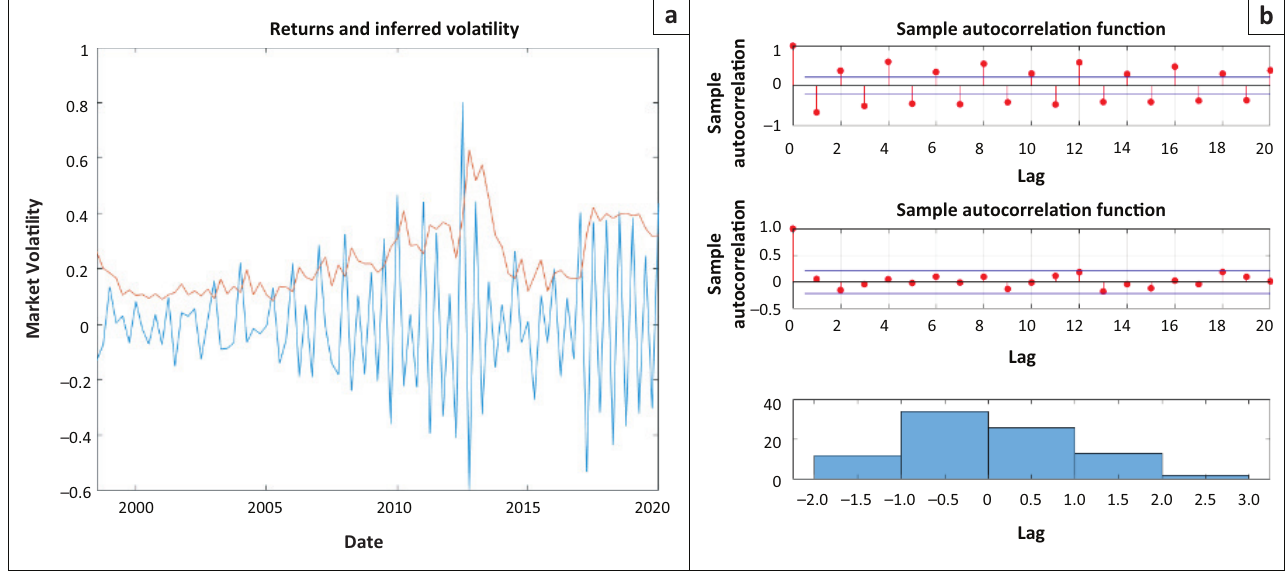
7. Modelling Global Art Price Index EU autoregressive integrated moving average quarterly data.